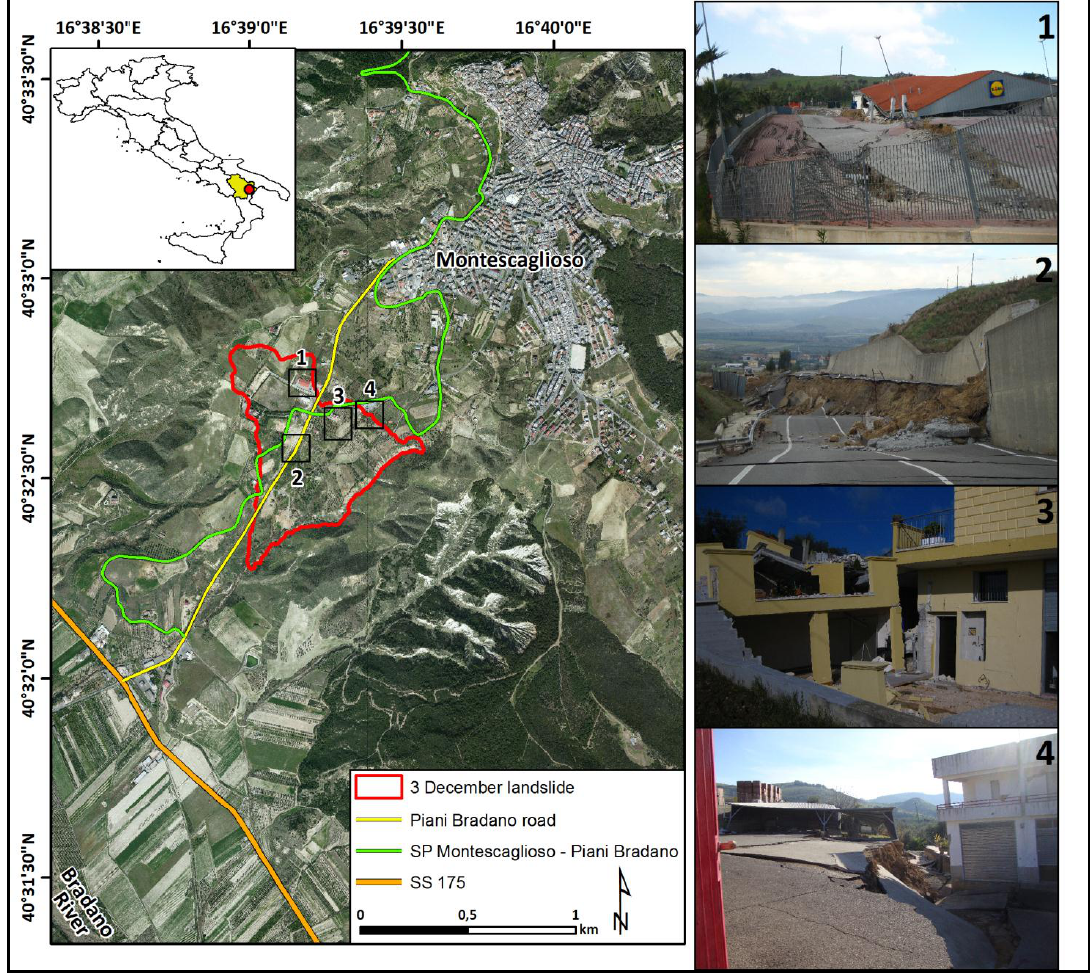
Figure 1. Location map of the 3 December 2013 Montescaglioso landslide. In the insets damaged buildings and disrupted roads are reported: ( 1 ) Collapsed supermarket; ( 2 ) Disruption to the Piani Bradano road; ( 3 ) Damage to a private house; ( 4 ) Damage to artisan warehouse.